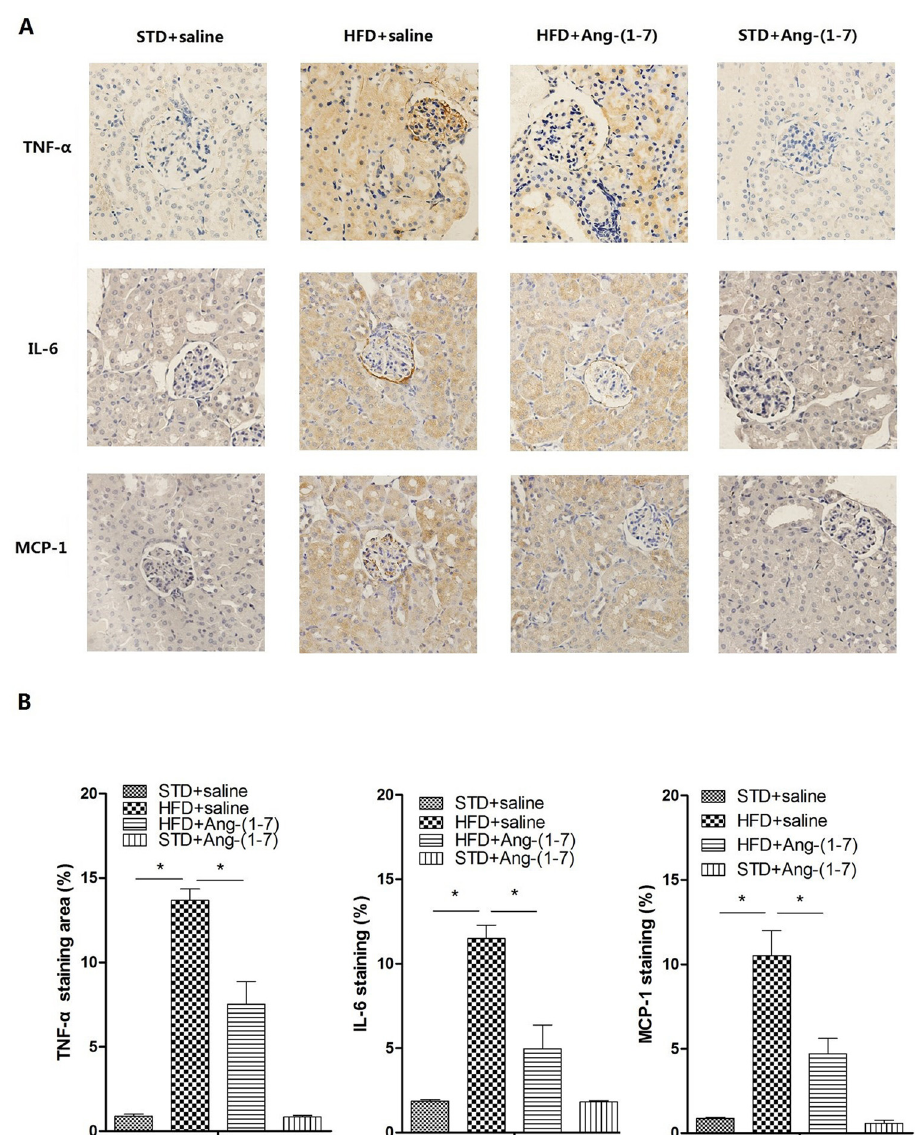
Fig 3. Immunohistochemical staining for inflammation in renal sections. Ang-(1 – 7) inhibits HFD- induced TNF- α , IL-6 and MCP-1 expression. A: Representative immunostaining of TNF- α , IL-6 and MCP-1 in all groups (magnification 400×) B: Quantification of TNF- α , IL-6 and MCP-1 staining was performed using Image-Pro Plus v 6.0. Values are expressed as means ± SD (n = 6), * P < 0.05.